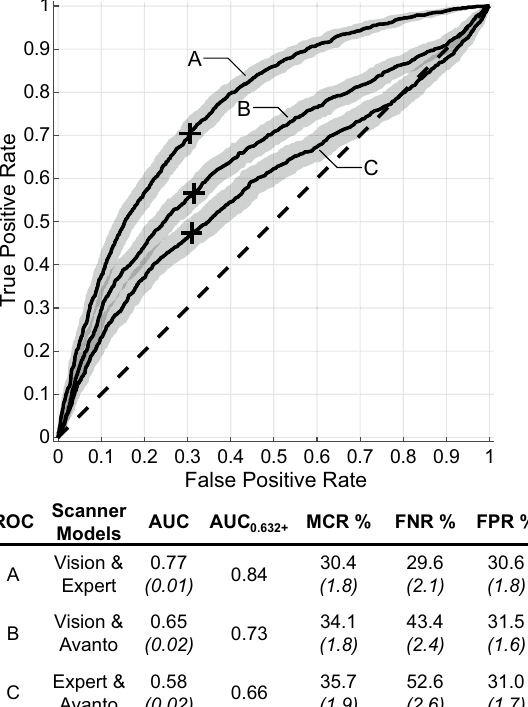
Figure 3. Error metrics across MR scanner models. The average ROC curves across bootstrapped repetitions are compared when using clinical and radiomic features only from pairings of the three primary MR scanner models used (Siemens Magnetom Vision, Magnetom Expert, and Avanto). As for Fig. 1, for each curve in this figure, associated error metrics, optimal operating point (+), and 95% confidence intervals (shaded band and values in parentheses) are